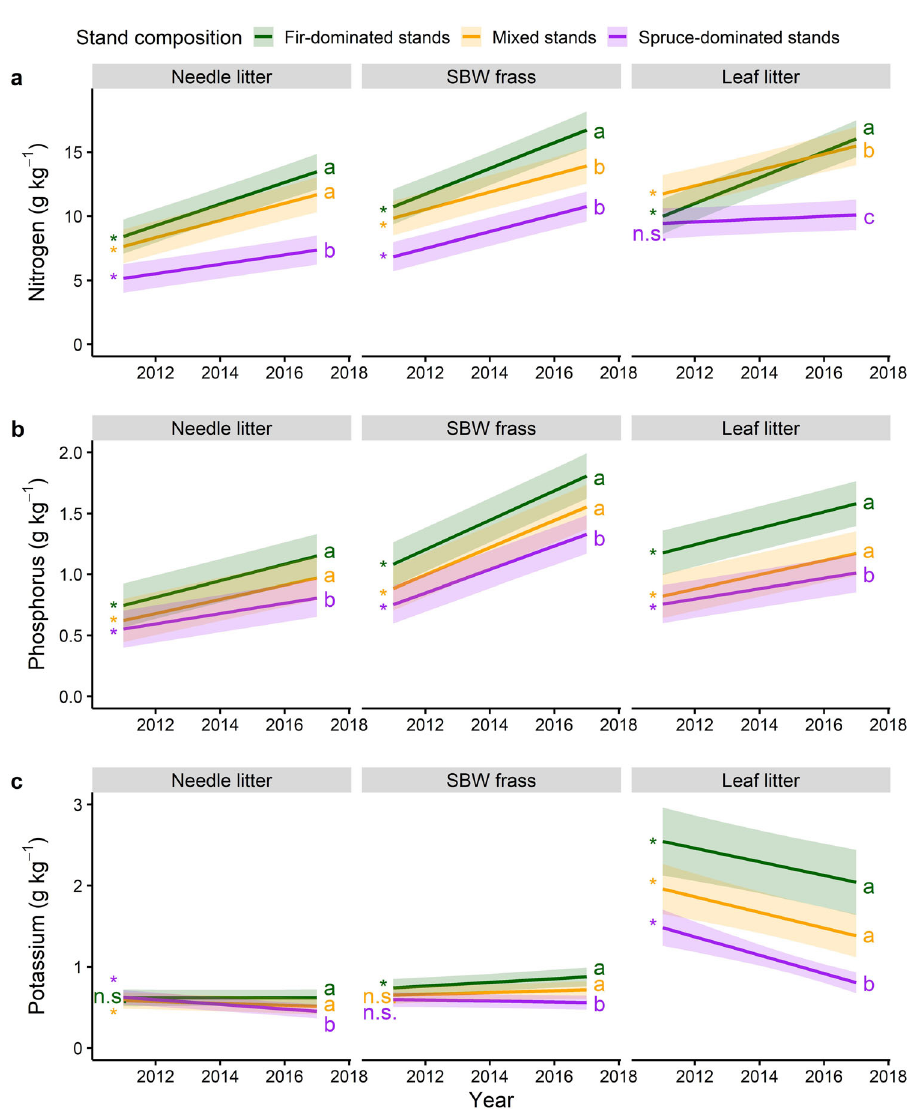
Fig. 2 Nutrients concentration in litter with annual progression of the outbreak. Fitted relationship for nitrogen ( a ), phosphorus ( b ), and potassium ( c ) concentrations (g kg − 1 ) with time (calendar years) and stand composition for different litter types. Shaded areas indicate 95% con fi dence intervals. Slopes signi fi cantly different from zero are represented by an asterisk and letters compare slopes among stand composition, separately for each litter type. Linear mixed-effects models were fi tted using a total sample size of 1360